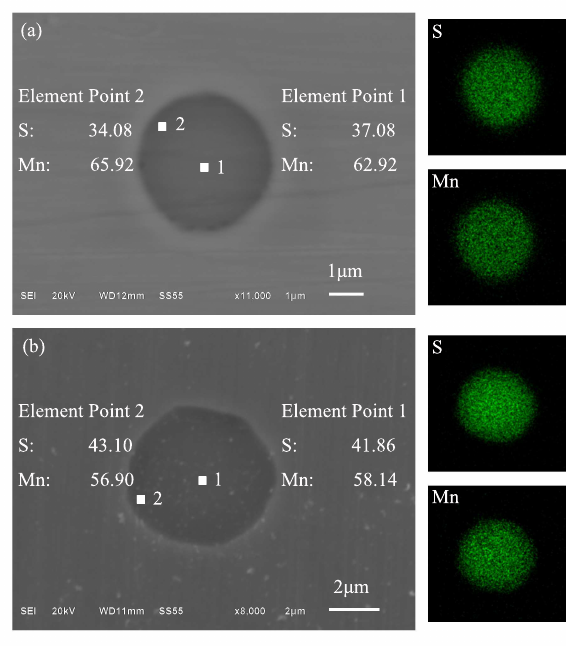
Figure 3: SEM micrographs and EDS mapping images for typical pure MnS (a) For Non-treated sample (b) For EAM-treated sample